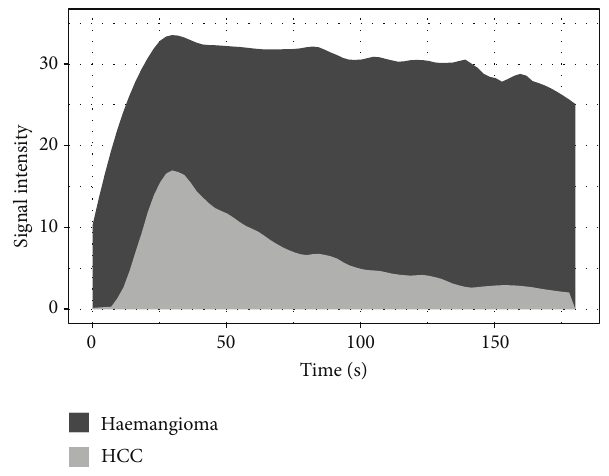
Figure 2: Time-intensity curve of 5 HCCs and 4 haemangiomas after local polynomial regression fitting using LOESS. RBV and RBF are directly proportional to the area under the curve and, therefore, benefit from a continuous registration to the late